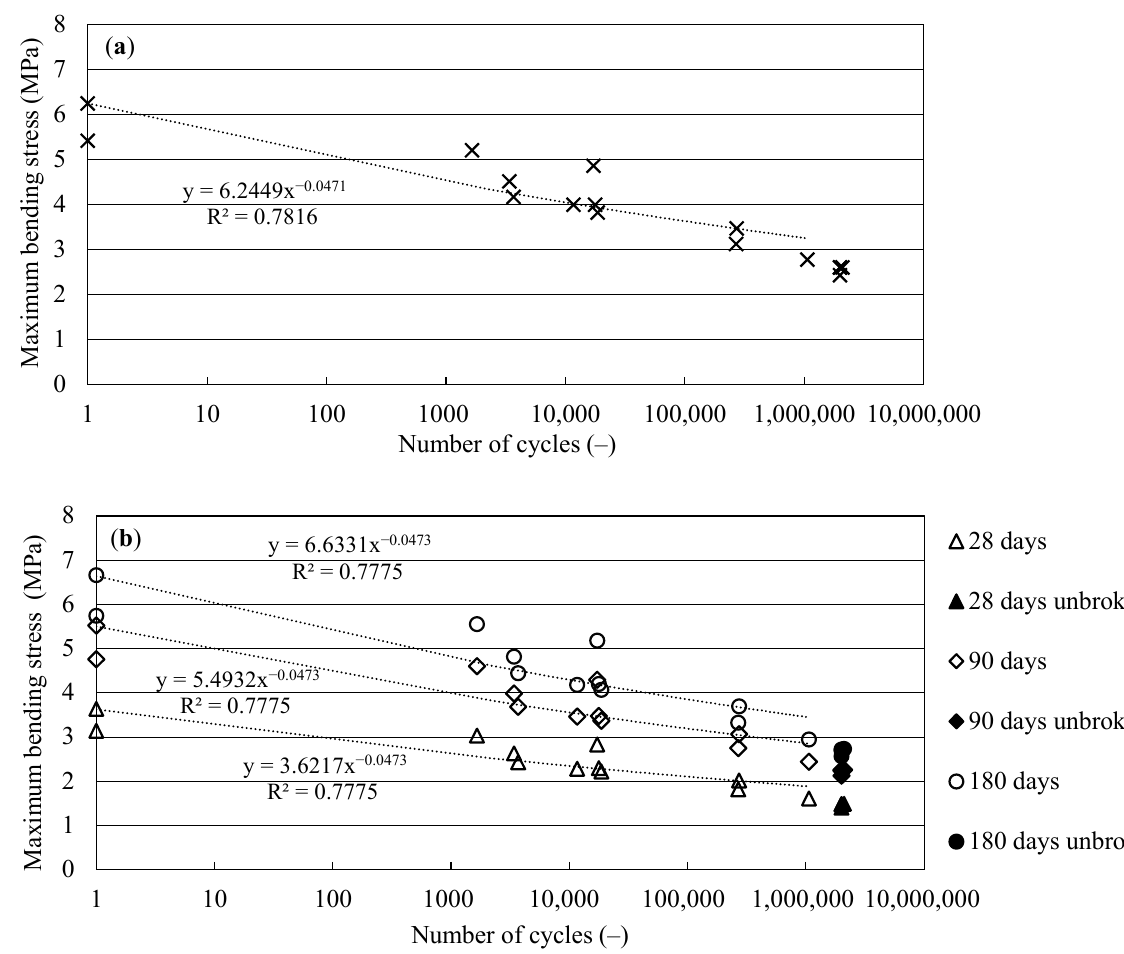
Figure 9. The S F − N curve for the investigated AAS composite plotted for measured data ( a ), the S F − N curve plotted for standardized data at the specimen’s age 28, 90, and 180 days ( b ); the horizontal axis is plotted in logarithmic